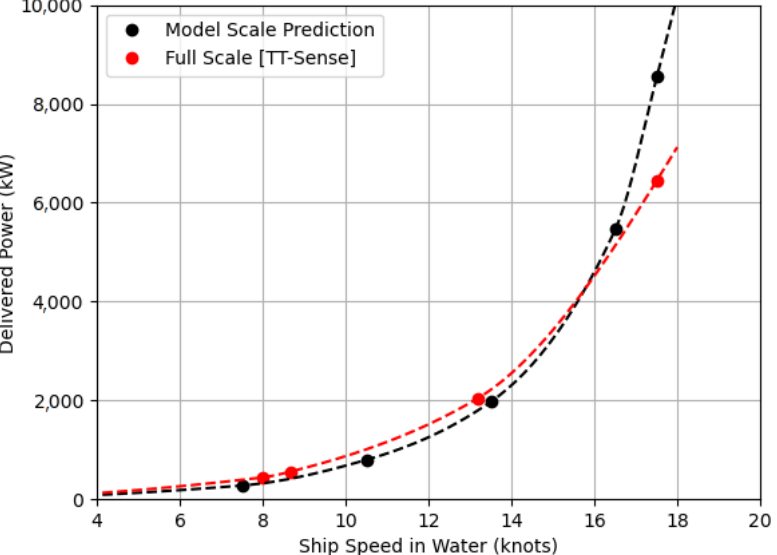
Figure 13. Comparison of the experimental model-scale [51] and full-scale effective